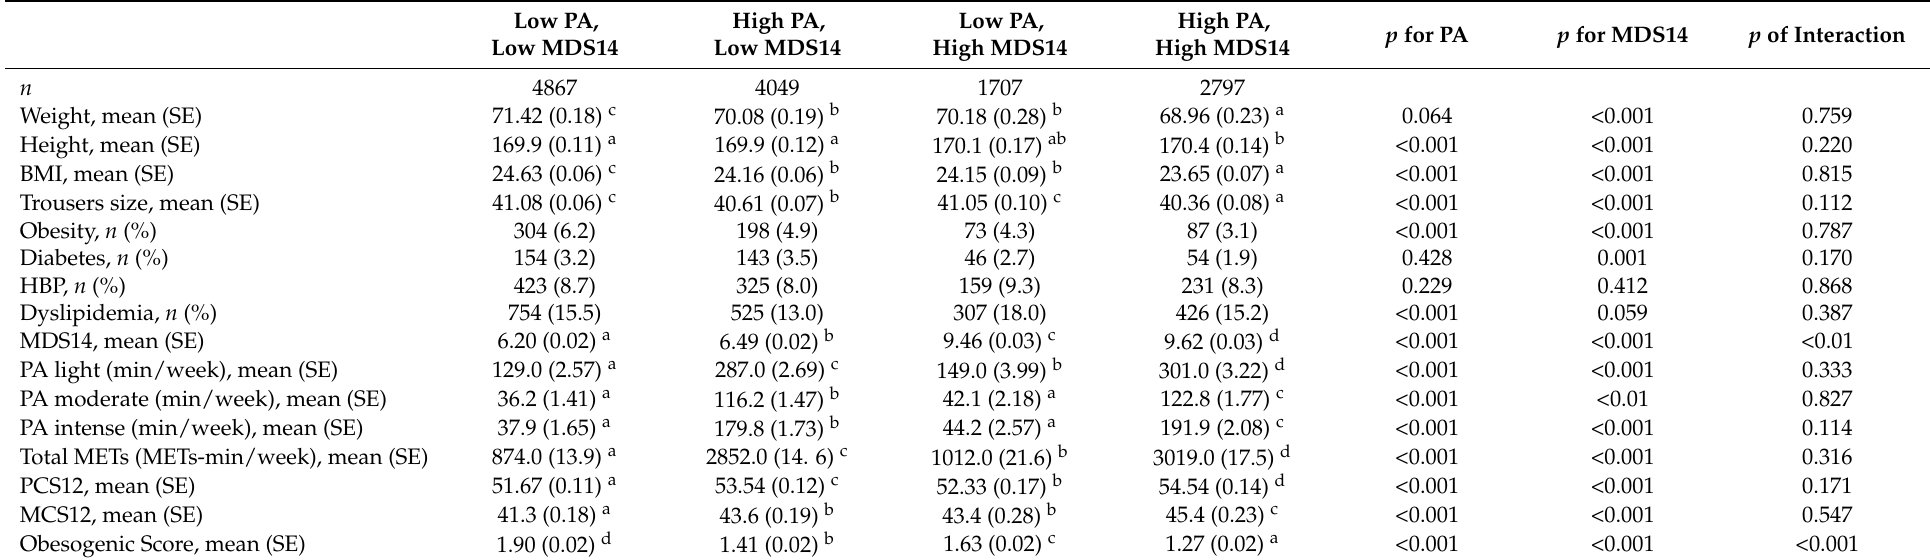
Table 3. Phenotypic characteristics, lifestyle, HRQoL and Obesogenic Score of the participants in the NUTRiMDEA study stratified by physical activity and diet categories analyzing for statistical interactions.